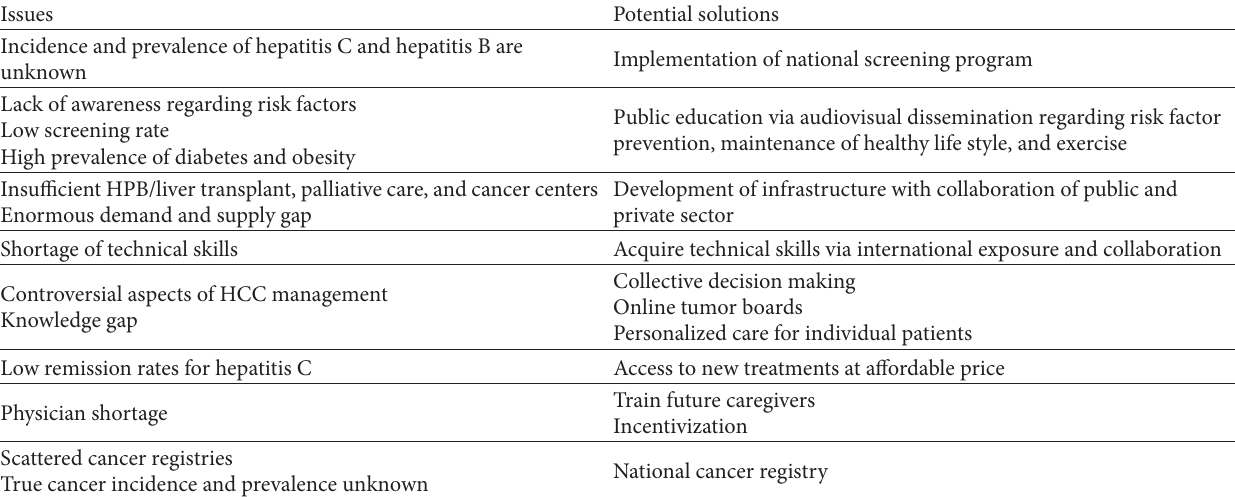
Table 1: Guidelines for HCC management in